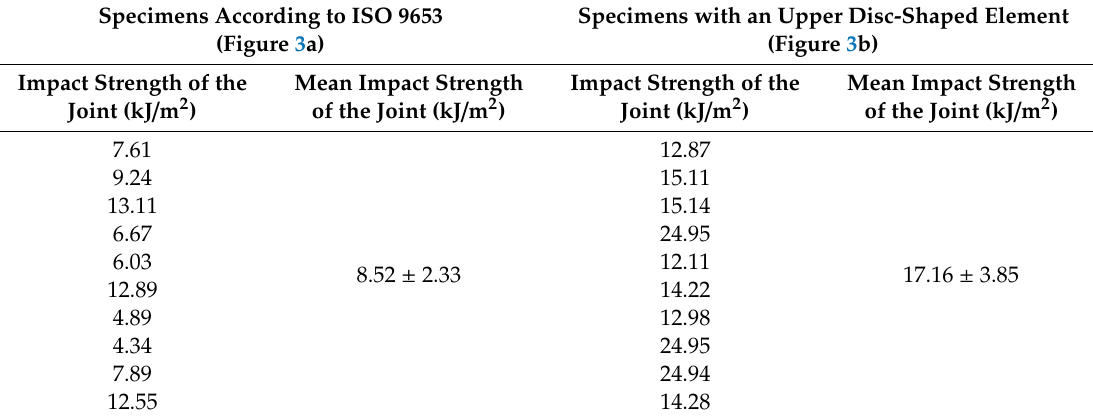
Table 1. The impact test results for block specimens (the mean impact strength is given with the calculated confidence intervals for a 95% level of confidence).